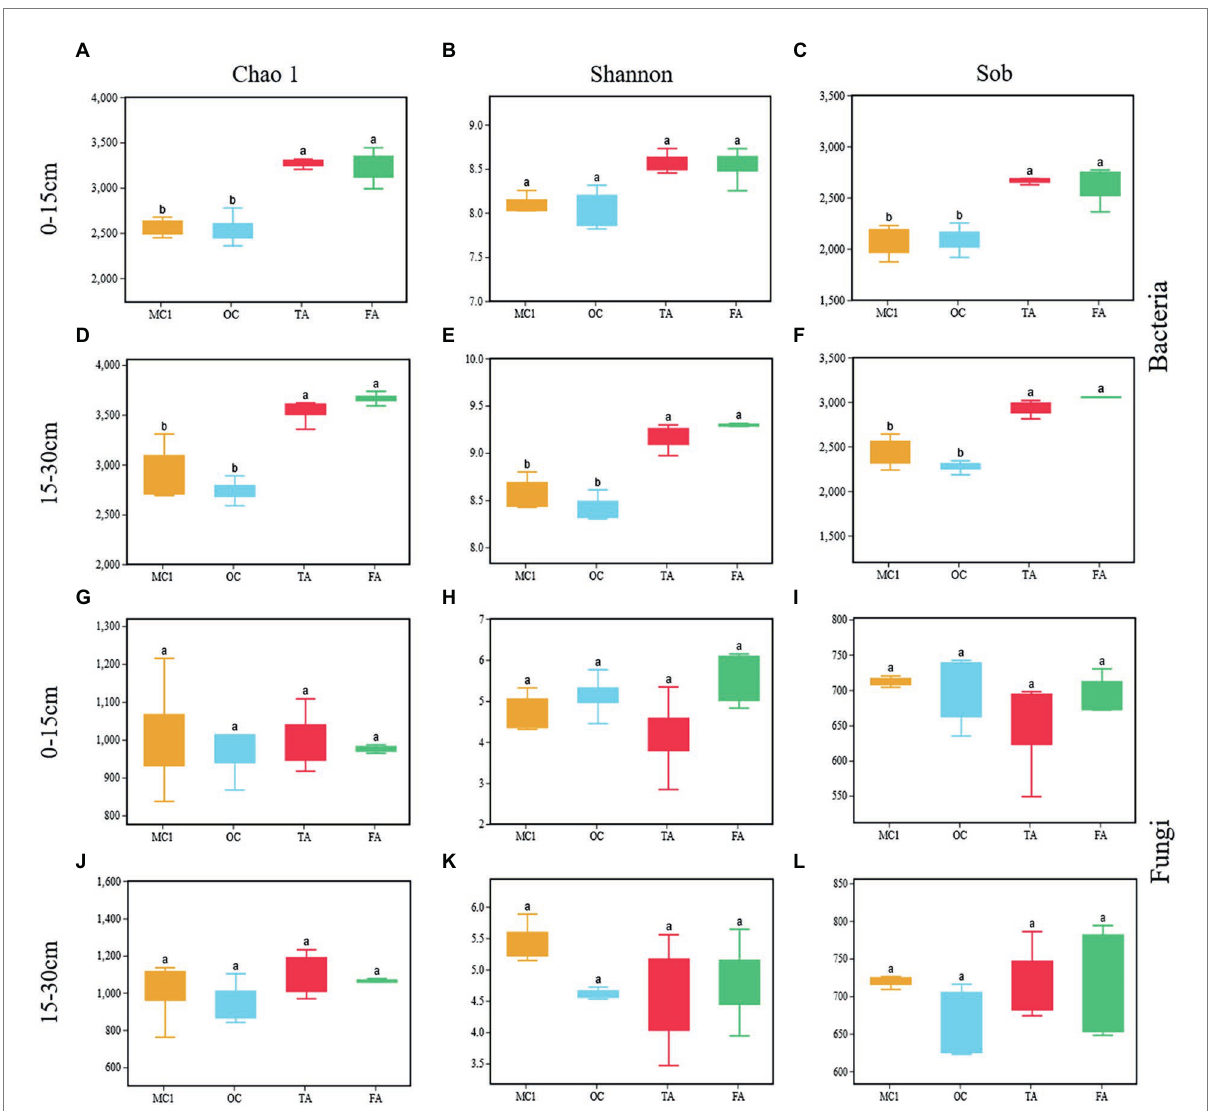
FIGURE 2 Box plots representing soil bacterial (A-F) and soil fungal (G-L) alpha diversity at the soil depths of 0-15 cm and 15-30 cm for different treatments, including Chao1, Shannon and Sob. MC1= multiyear corn planting. OC = two years of alfalfa-corn rotation, TA = three years of alfalfa planting, and FA= four years of alfalfa planting. Different lowercase letters indicate a significant difference between treatments ( p <